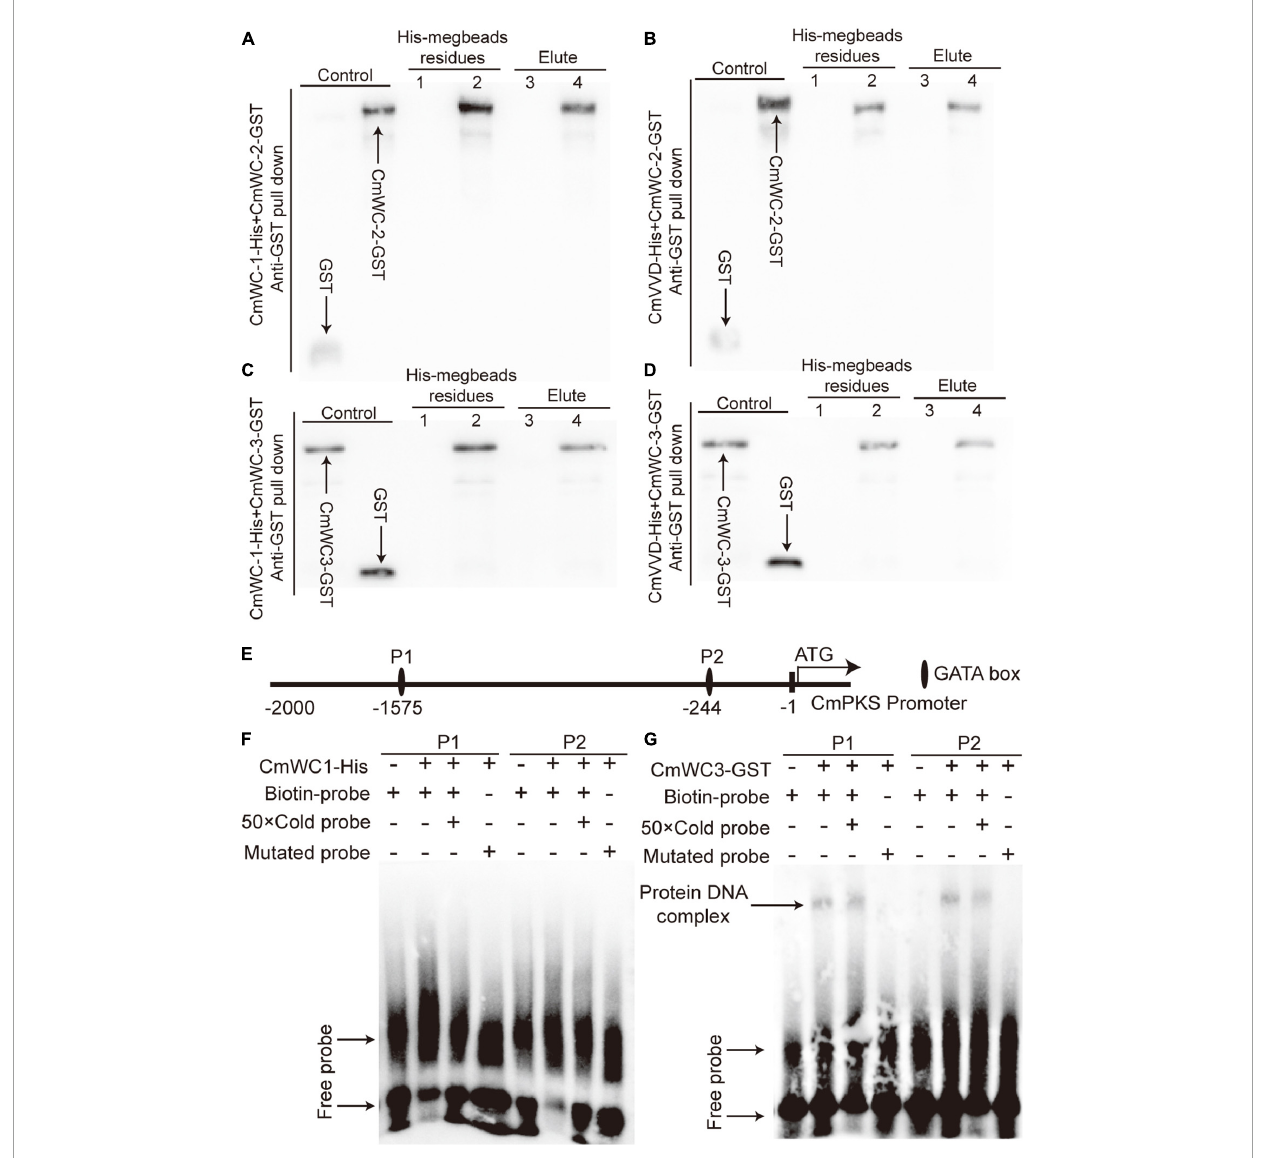
FIGURE7 The relationship of CmWC-1, CmWC-2, CmWC-3, CmVVD, and CmPKS. Panels (A–D) respectively indicates the protein pull-down result of CmWC-1 with CmWC-2, CmVVD with CmWC-2, CmWC-1 with CmWC-3, and CmVVD with CmWC-3. Lane 1, GST + CmWC-1-His or CmVVD-His megbeads; lane 2, CmWC-2-GST or CmWC-3-GST + CmWC-1-His or CmVVD-His megbeads; lane 3, GST + CmWC-1-His or CmVVD-His elute; lane 4, CmWC-2-GST or CmWC-3-GST + CmWC-1-His or CmVVD-His elute. GST, CmWC-2-GST, and CmW-C3-GST as a control. (E) The GATA